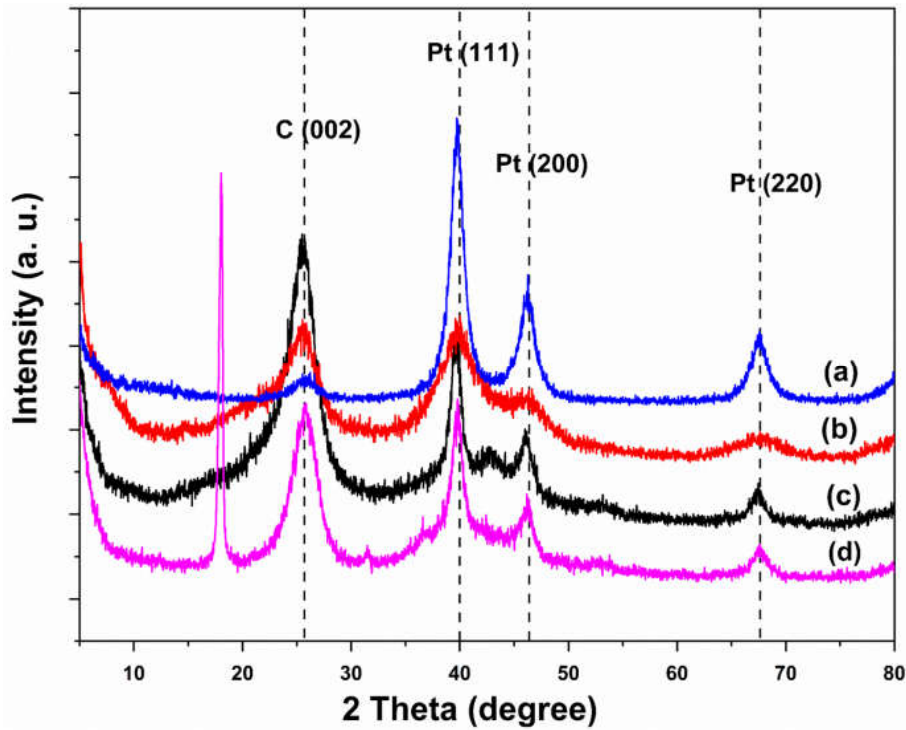
Figure 3. XRD graph of various electrocatalysts: ( a ) MWCNT-Pt, ( b ) MWCNT-PBI-Pt, ( c ) MWCNT- Nafion-Pt, and ( d ) MWCNT-PTFE-Pt.